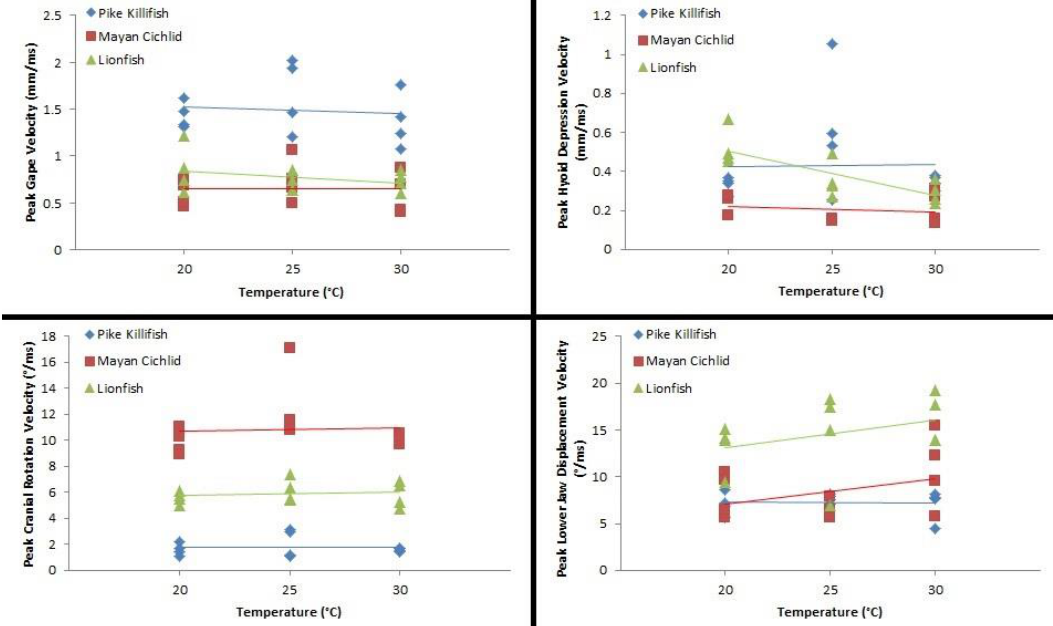
Figure 4. Scatterplot showing the relationship between each of the four kinematic-velocity variables and feeding temperature 20 °C, 25 °C, and 30 °C. Results of the regression analysis that quantified the effect of temperature on each of the kinematic events are presented in Table 1. Table 1. Results of the regression analysis examining the effects of temperature on the kinematic velocities of maximum gape, hyoid depression, cranial rotation and lower-jaw rotation.